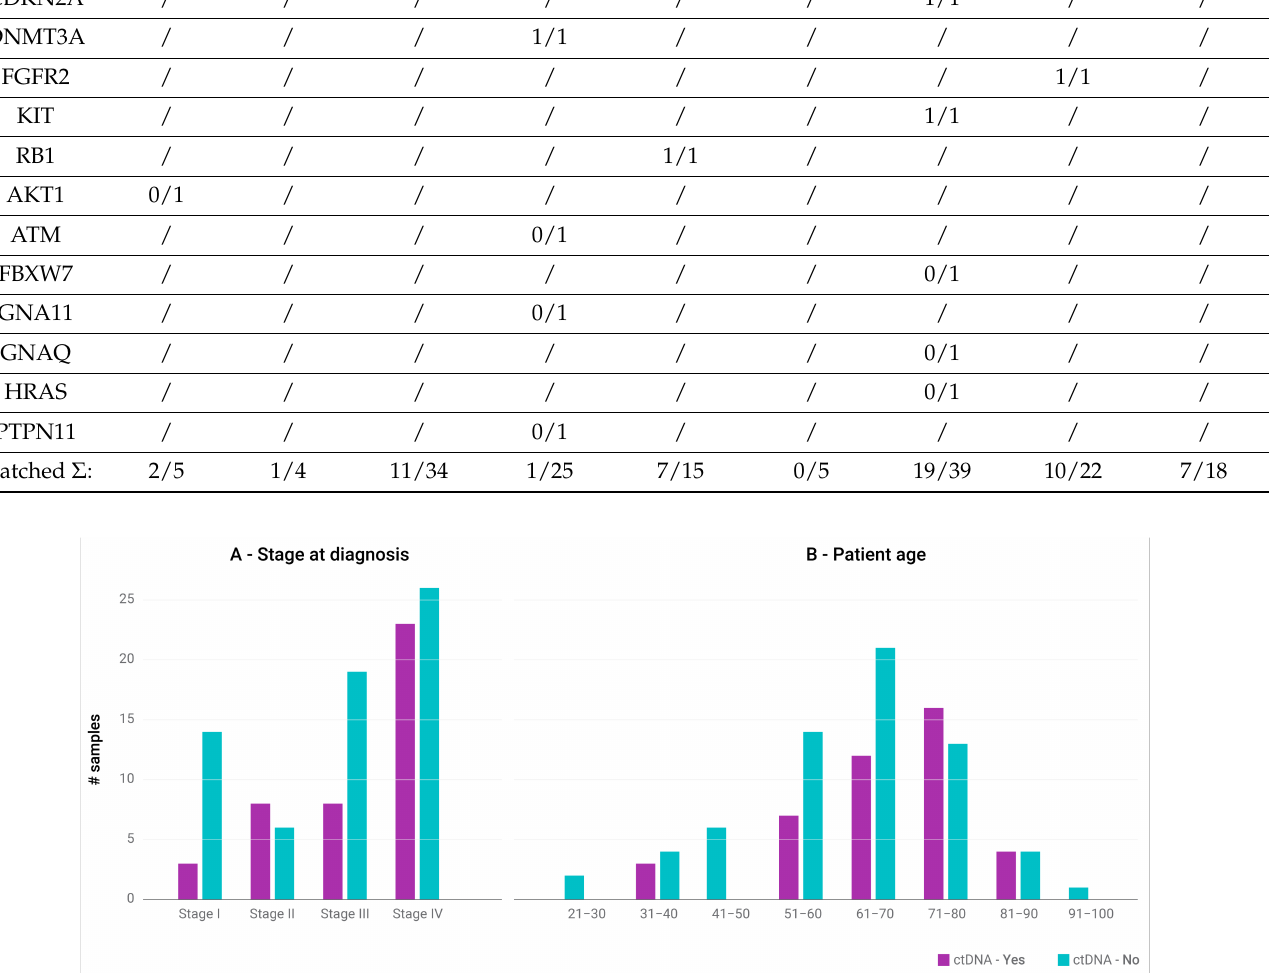
Figure 2. Correlation between sample count (with or without ctDNA presence) and ( A ) stage at diagnosis, ( B ) patient